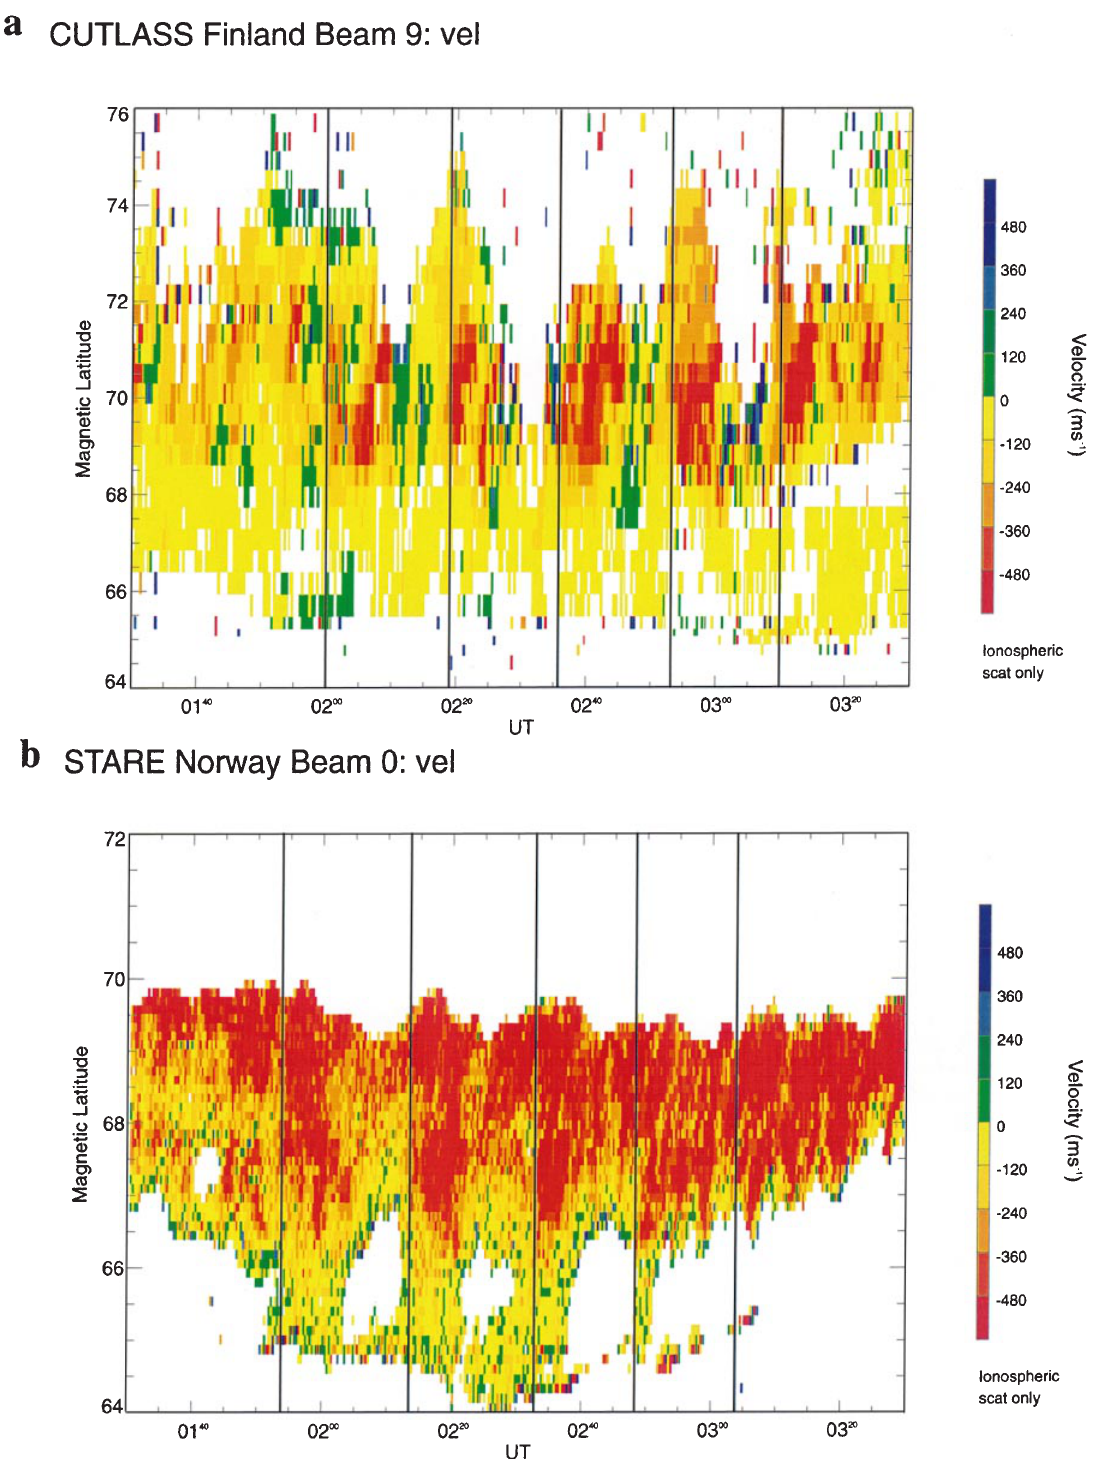
Fig. 4. a Line-of-sight velocities from beam 9 of the CUTLASS Finland radar as a function of magnetic latitude and time, showing dynamic ionospheric features associated with the auroral omega bands. Positive Doppler velocities are towards the radar (equator-